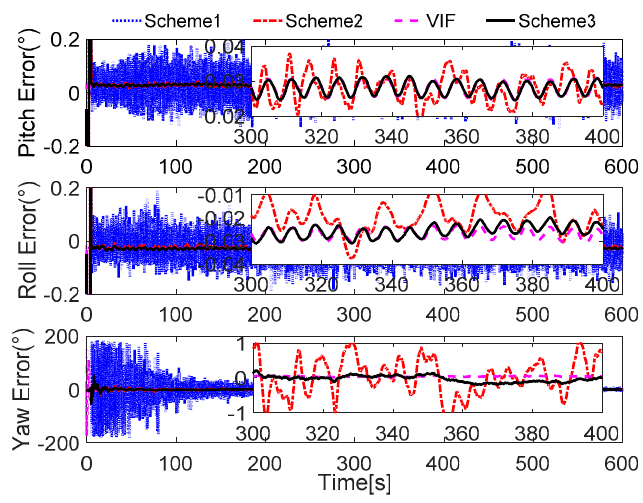
Figure 8. Curves of alignment errors.